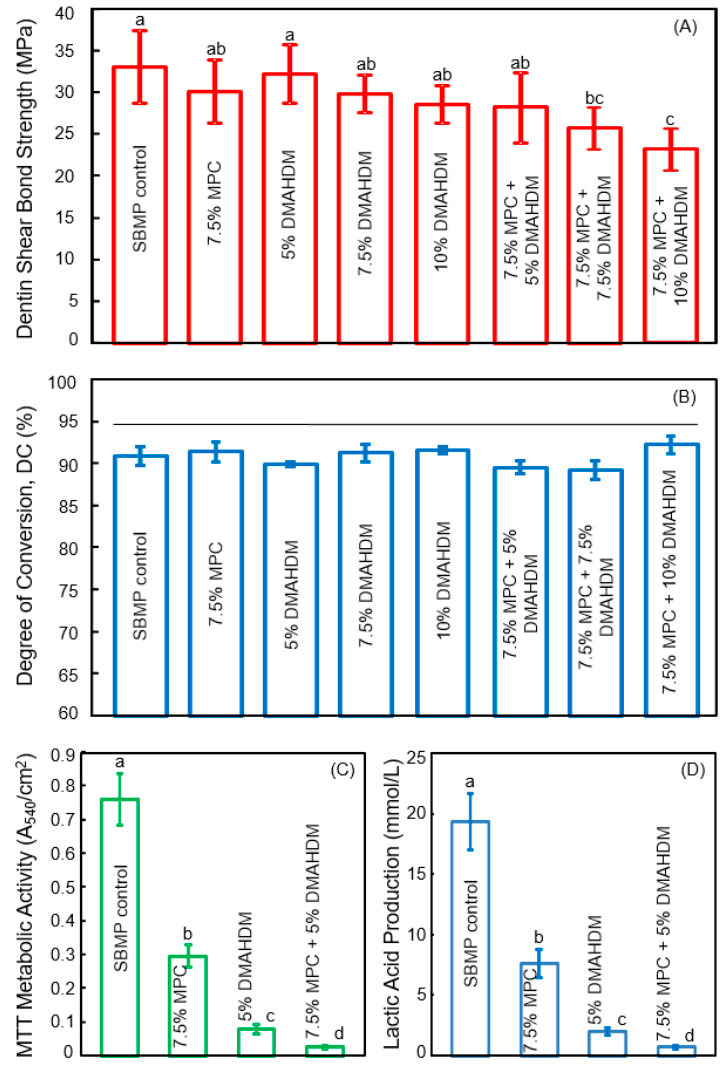
Figure 3. Protein-repellent and antibacterial bonding agent. ( A ) Dentin bond strength; ( B ) Degree of polymerization conversion (DC). The horizontal line indicates values that are not significantly different ( p > 0.1); ( C ) Metabolic activity of 2-day biofilms; ( D ) Lactic acid production of 2-day biofilms. Values with dissimilar letters indicate significantly different values ( p < 0.05). (Reproduced with permission from [51]. Elsevier, 2015)